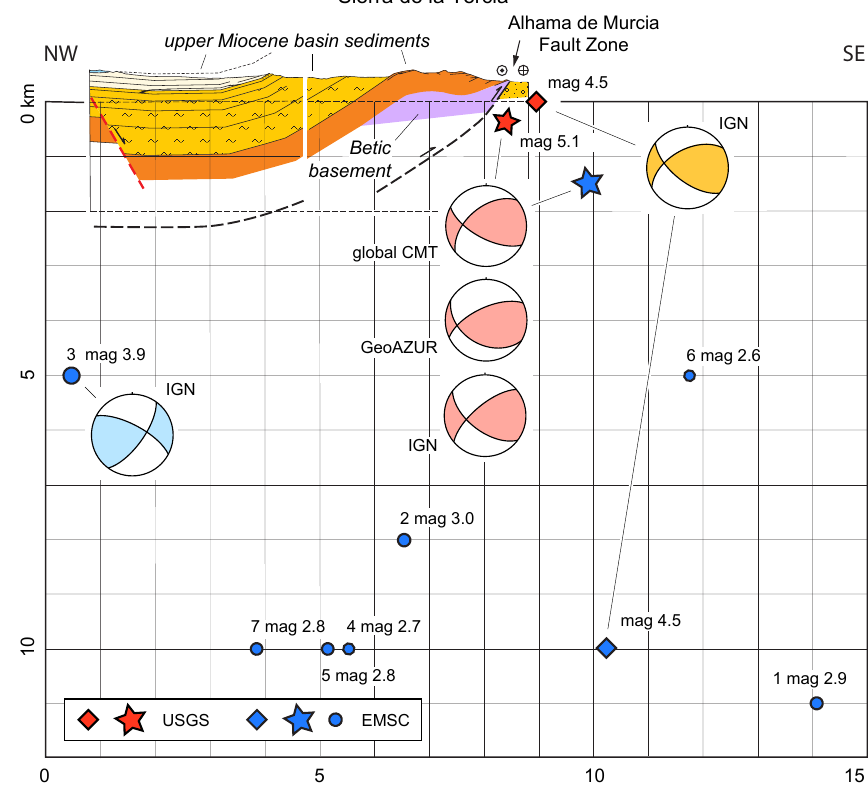
Fig. 3. Section across the Sierra de la Tercia and southern Lorca basin, perpendicular to the trend of the Alhama de Murcia fault and through the epicentre location of the main mag 5.1 earthquake from the USGS, with reported seismic events and fault plane solutions. All fault plane solutions are shown as seen in a map view (i.e. with the periferal circle horizontal). Diamonds: foreshock, stars: main earthquake, circles: aftershocks. Geological section from Meijninger and Vissers (2006). For further explanation see